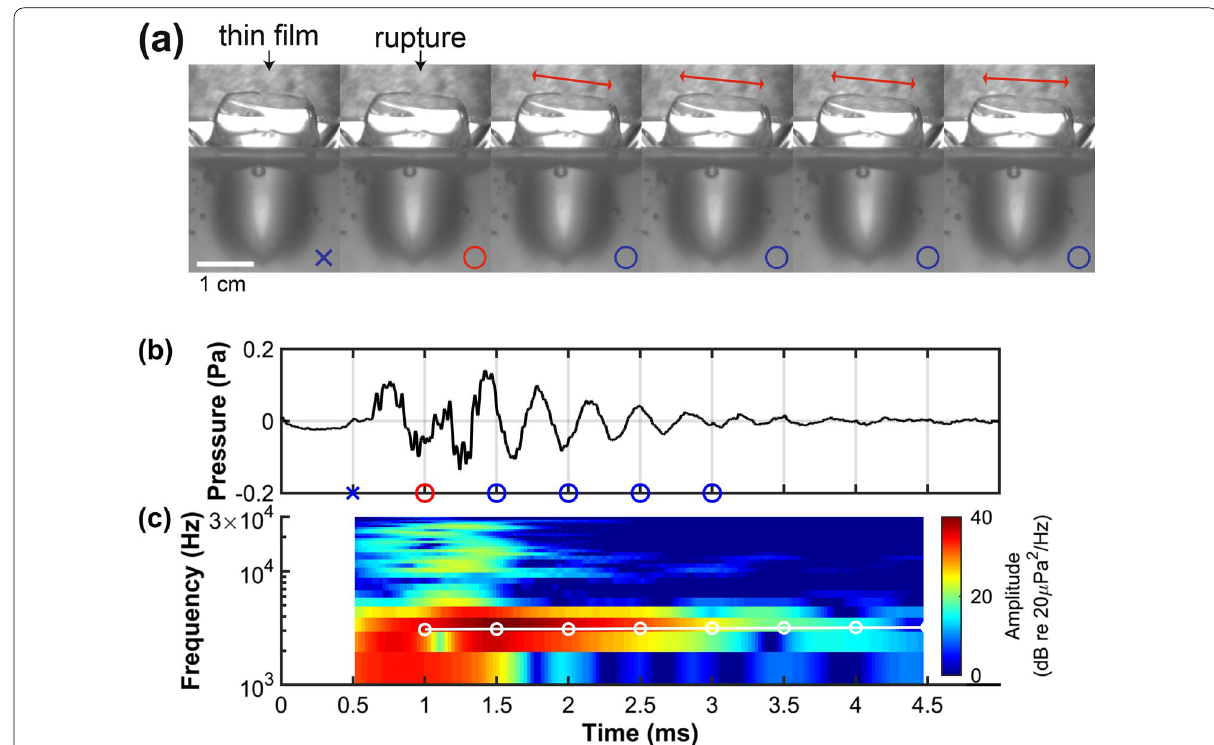
Fig. 8 An example of Helmholtz resonance excited after a thin film bursts (case 4b). V = 6 cm 3 bubble bursts while it is rising in a suspension of φ = 0.4 . a Time-lapse images (see Additional file 4: Movie 4). Red arrows indicate the aperture. b Waveform (detrended, highpass filtered at 800 Hz). c Spectrogram of ( b ) using a 1.024 ms sliding window and a 1.000 ms overlap. (cid:31) indicates the f H calculated using Eq. (11) and measured R